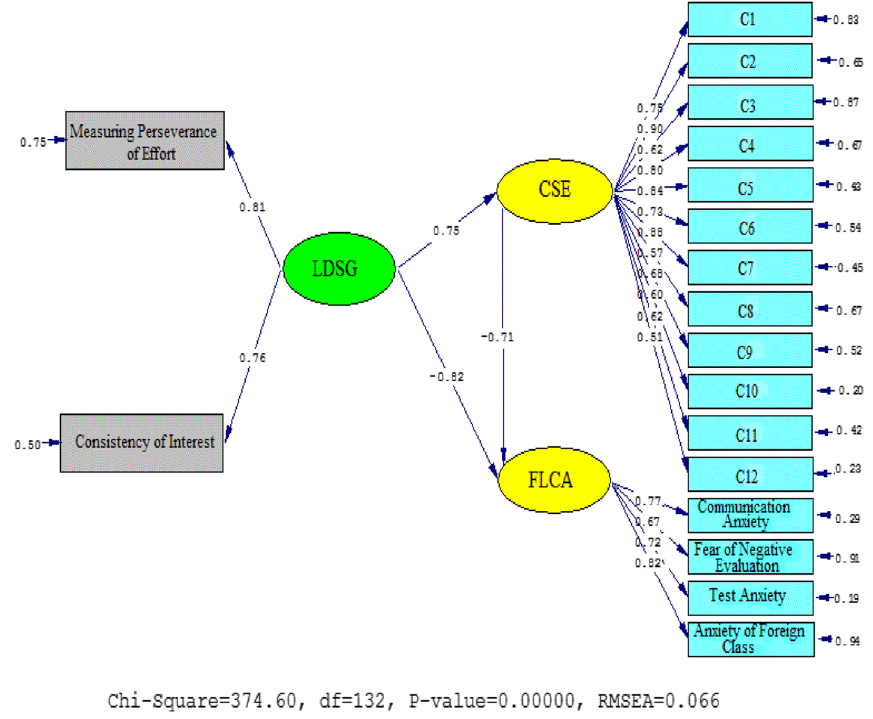
Fig. 2 Schematic representation of path coefficient values for the relationships between L2-grit, CSA, and FLA (model